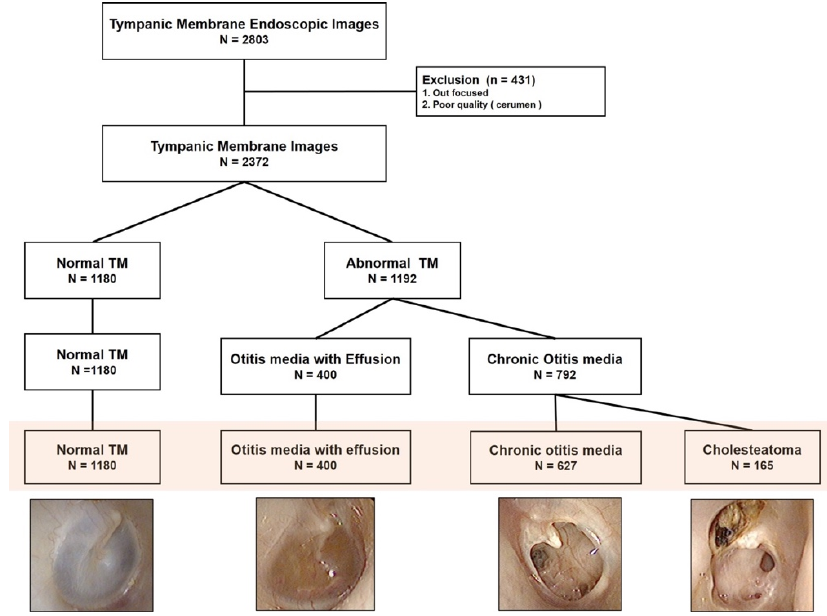
Figure 1. Acquisition and labeling of the tympanic membrane images.